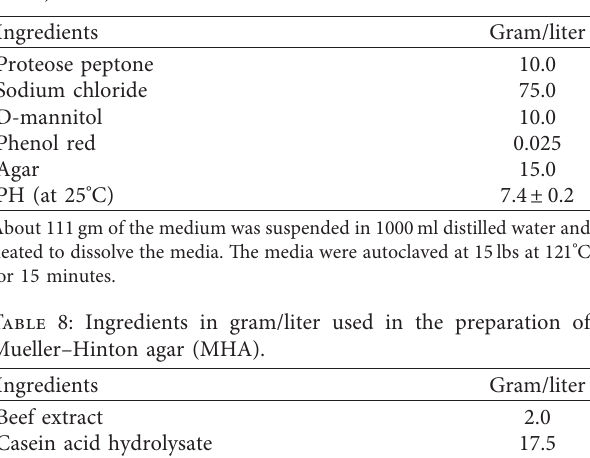
Table 7: Ingredients used in the preparation of Mannitol salt agar (MSA).